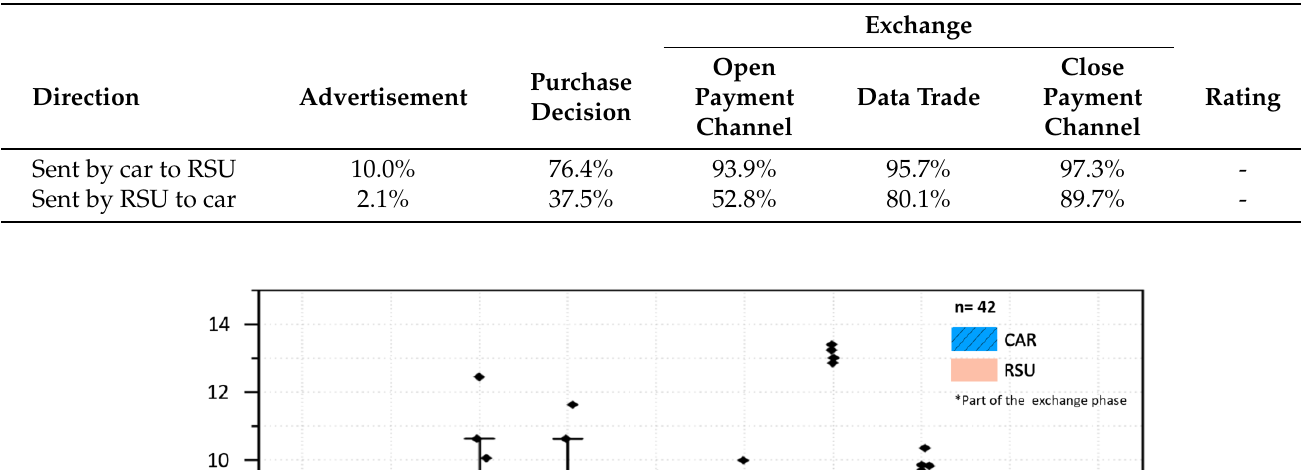
Table 1. Average success rate of DSRC messages exchanged between X-Nodes for different data trading phases. No DSRC messages are exchanged between X-Nodes during the rating phase.